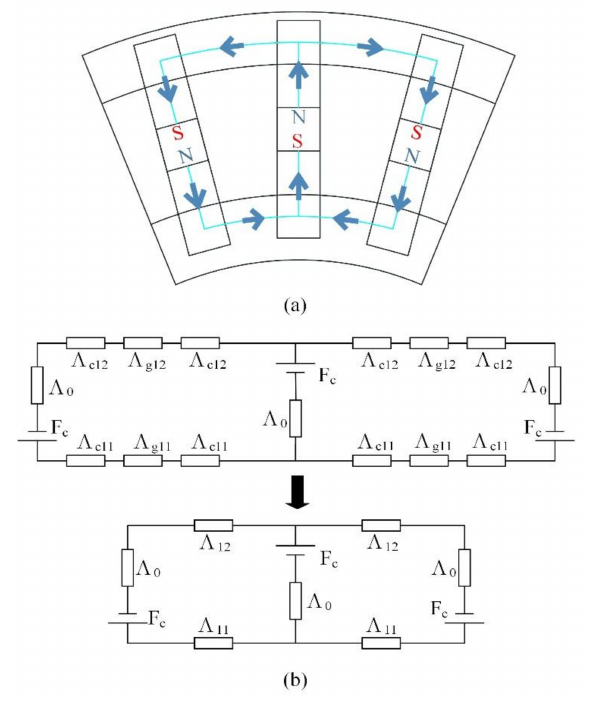
Figure 3. The transverse cross section: ( a ) The magnetic circuit; ( b ) The equivalent magnetic circuit.